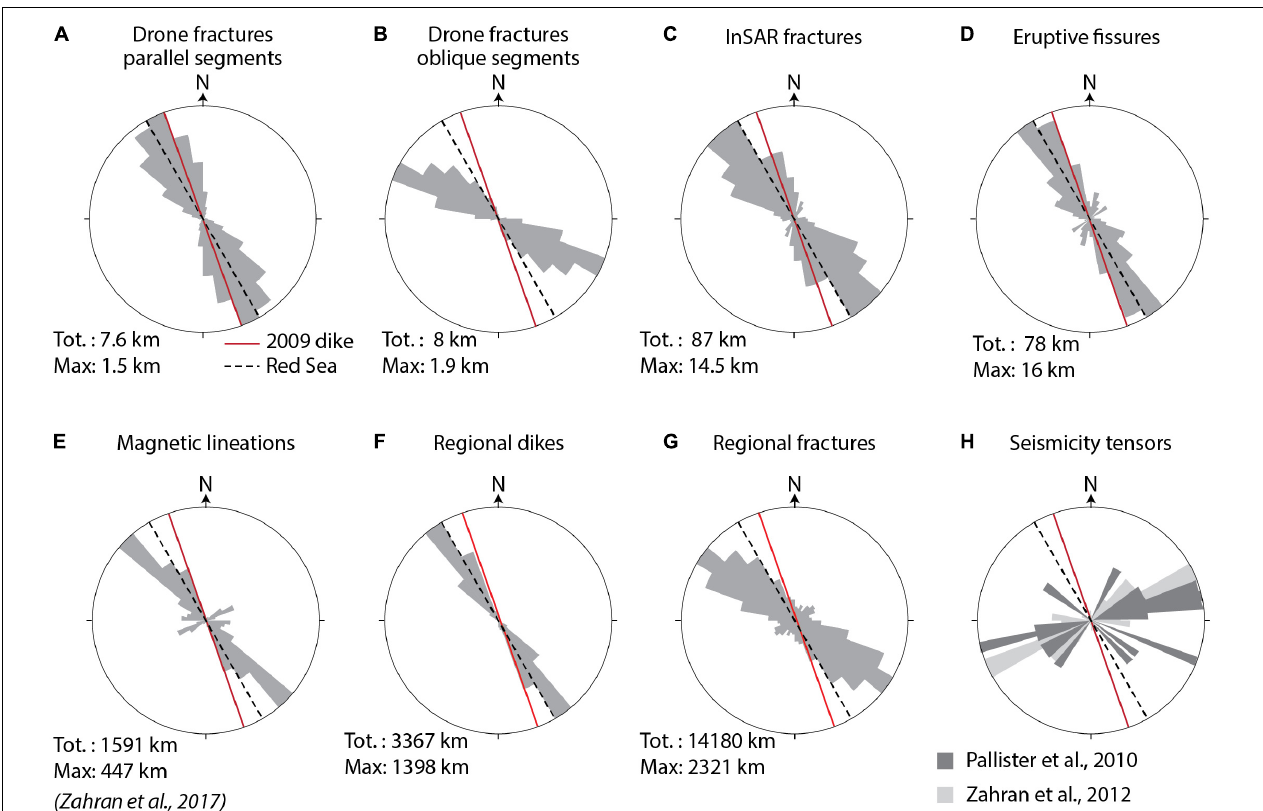
FIGURE 9 | Rose diagrams showing orientations of (A) fractures in dike-parallel; (B) in oblique segments; (C) fractures extracted from InSAR data (Jónsson, 2012) in the north-western Harrat Lunayyir of the 2009 dike intrusion (see also Figures 1b,c ); (D) eruptive fissures (or crater rows) belonging to the Harrat Lunayyir volcanic field and mapped by using BingMaps and Google Earth images (see also Figure 1b ); (E) magnetic lineations in the whole Harrat Lunayyir volcanic field (Zahran, 2017; Zahran et al., 2017); (F) coastal tertiary regional dikes (mapped from USGS map 1963); (G) regional faults and undefined lineaments in the northern (from 23 ◦ 00 (cid:48) to 28 ◦ 00 (cid:48) N) Arabian Shield (Beziat and Bache, 1985; Figure 1a ). Total length (Tot.) and maximum length of fractures for the highest frequency azimuth (Max) are reported for each rose diagram. (H) Tensional stress axis orientation obtained by using focal mechanisms from earthquakes with M4.0 to M5.4 during the seismic crisis associated with the 2009 intrusion event (Pallister et al., 2010) or 84 earthquakes related to the May 19th 2009 swarm (Al-Zahrani et al., 2012). Red solid and black dashed lines, respectively indicate the inferred 2009 dike strike (N340 ◦ , Pallister et al., 2010) and the overall Red Sea orientation (N330 ◦